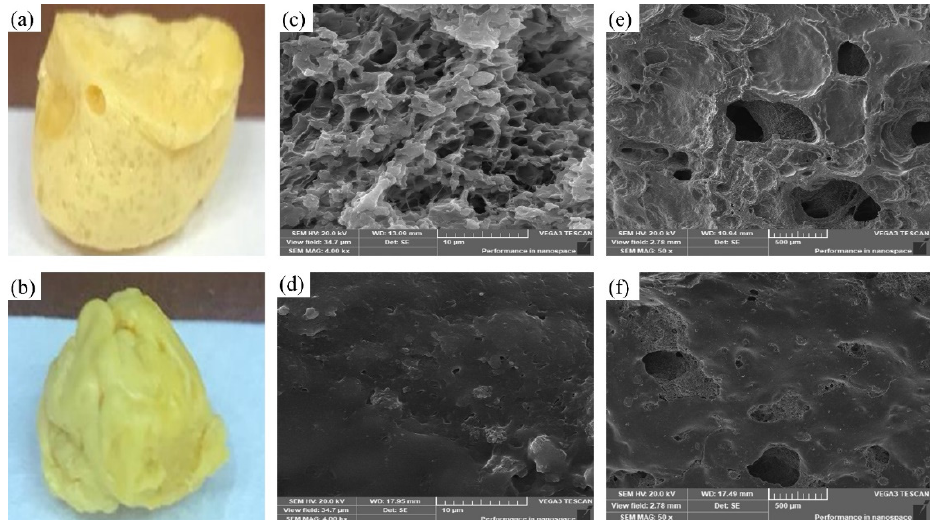
Figure 7. Photographs of ( a ) D-ZIFI 1 and ( b ) D-ZIFI 2 implants. SEM images of the cross-sectional morphologies of ( c ) D-ZIFI 1 and ( d ) D-ZIFI 2 after immersion in PBS for 1 day and ( e ) D-ZIFI 1 and ( f ) D-ZIFI 2 after immersion in PBS for 7 days.